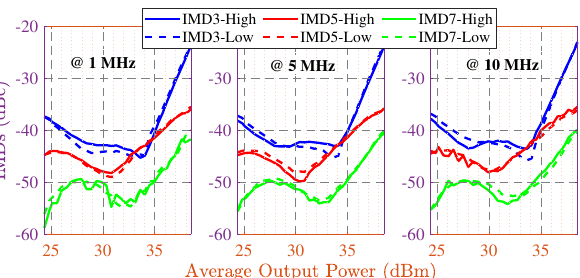
Figure 9. Measured high and low IMDs with 1 MHz, 5 MHz, and 10 MHz tone spacing